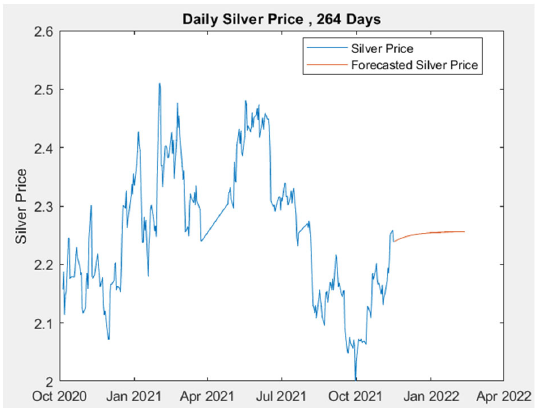
Fig. 13. Silver Price Forecast Chart With